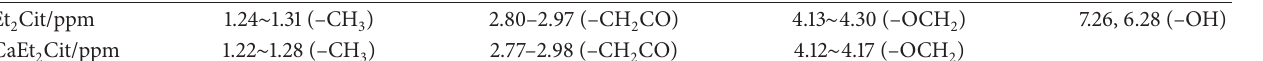
Cit and CaEt Cit. 2 2